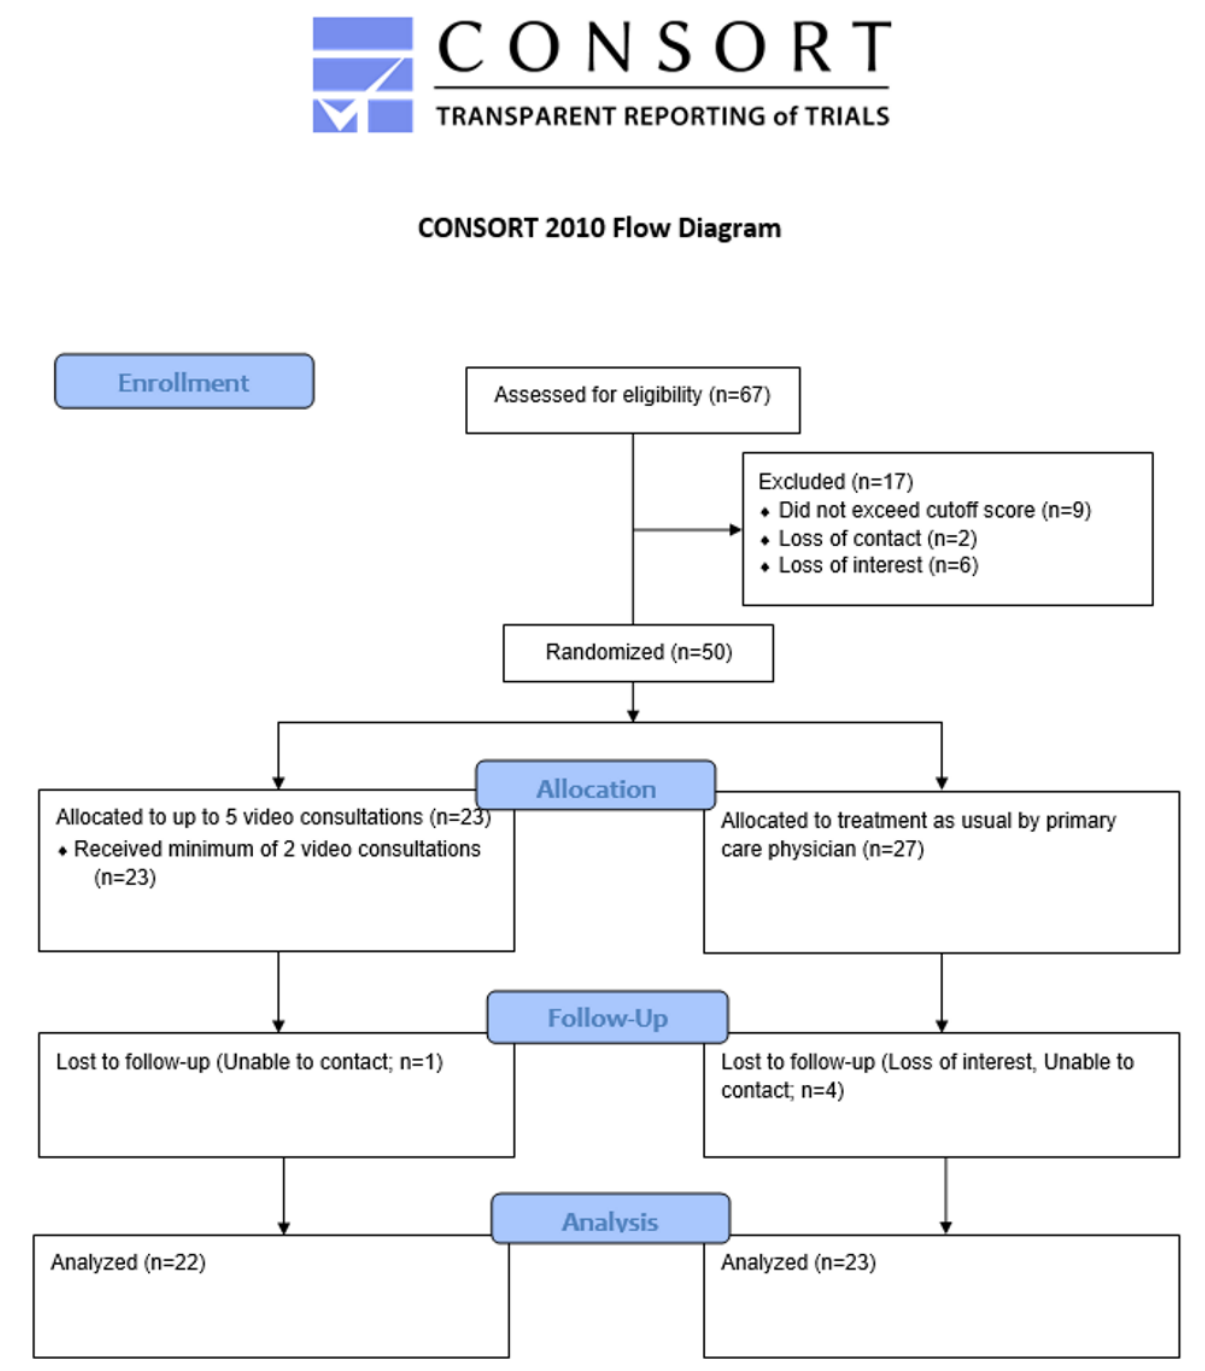
Figure 1. CONSORT (Consolidated Standards of Reporting Trials) flow